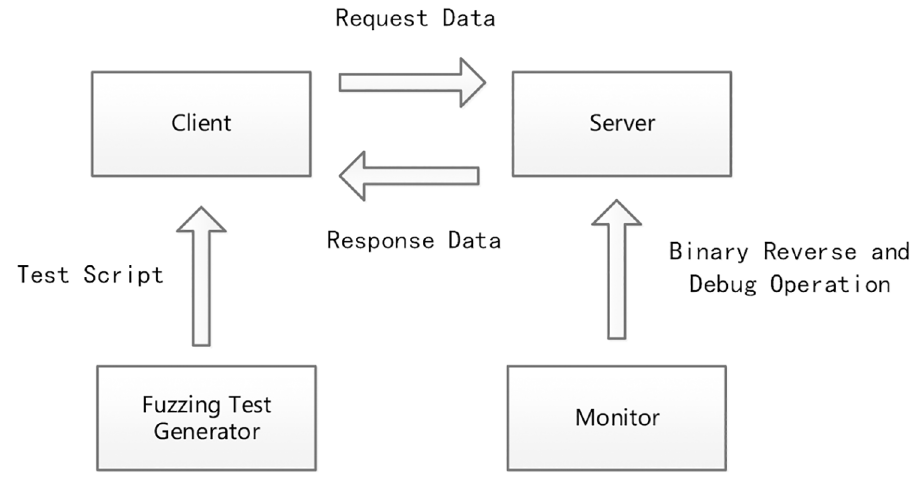
Fig 2. Vulnerability detection in C-S mode.